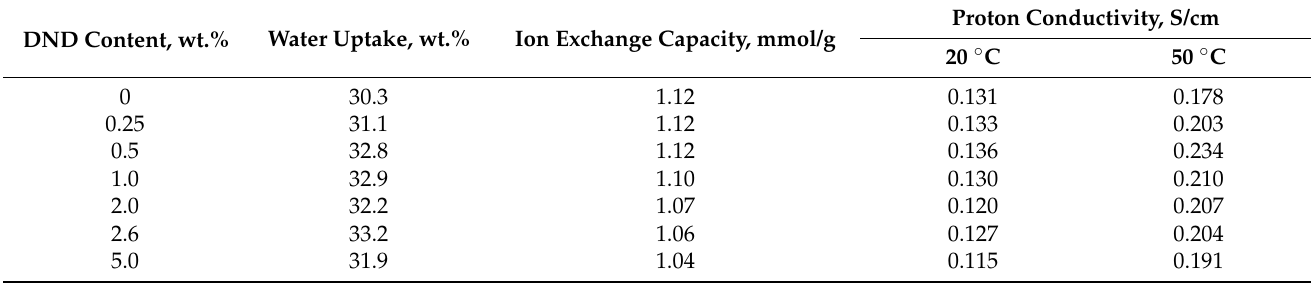
Table 1. Physical parameters for the Aquivion ® -type membranes with and without detonation nanodiamonds